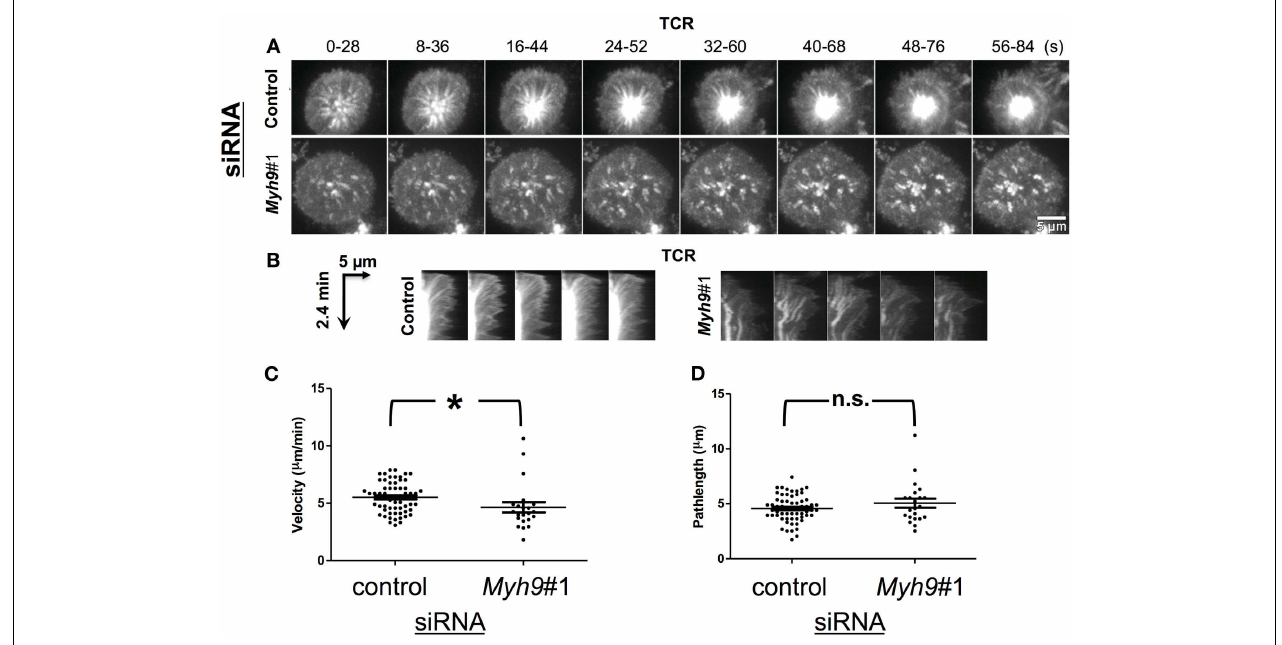
FIGURE 4 | MYH9 is not required for microcluster transport. (A) Maximum intensity projection ofTCR microclusters of Myh9 #1 and control siRNA-treated cells labeled with Alexa568-H57 Fab (TCR); 30s of imaging (15 frames) were condensed into one image every 8s, to represent the movement ofTCR microclusters. (B) Radial kymograms shows microcluster tracks over a period of 2.4min in a control siRNA- or Myh9 #1 siRNA-treated cell (arrow shows increasing time). Note that tracks in Myh9 #1 siRNA cells are wavy and lack termination into cSMAC.